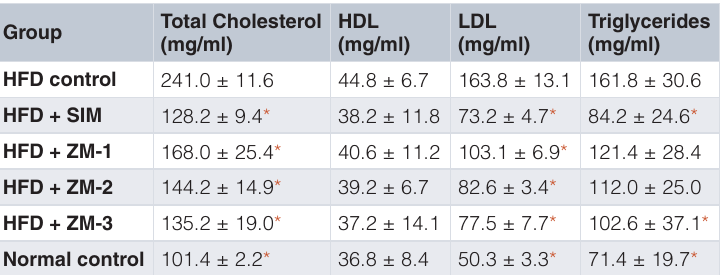
Table 1. Effect of Z. montanum and simvastatin total cholesterol, triglycerides, high density lipoproteins (HDL), and low density lipoproteins (LDL) level.